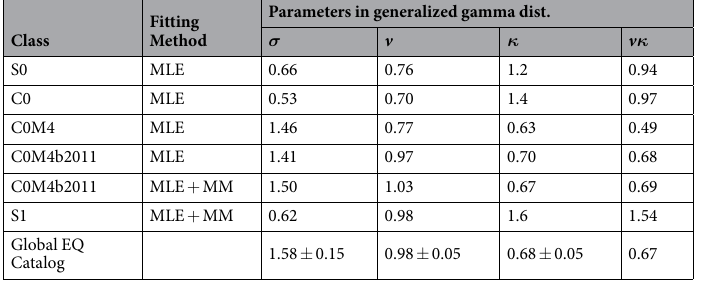
Table 2. Results of fitting a generalized gamma distribution. For purposes of comparison, we rescaled inter- time in each dataset by multiplying the mean rate of seismicity 22 . The estimates of parameters are based on maximum likelihood estimation (MLE), or the hybrid of MLE and moment matching (MM) as described in section of Discussion. Class C0M4 denotes a class of conventional earthquakes with M w ≥ 4 of class C0, whereas class C0M4b2011 denotes conventional earthquakes that are obtained by restricting class C0M4 to before 2011 (hence, no influence of the 2011 Tohoku-oki EQ). The difference of parameters between C0M4 and C0M4b2011 reflects the change in seismicity after the Tohoku-oki EQ. As a reference, the results based on a global earthquake catalog 22 are also